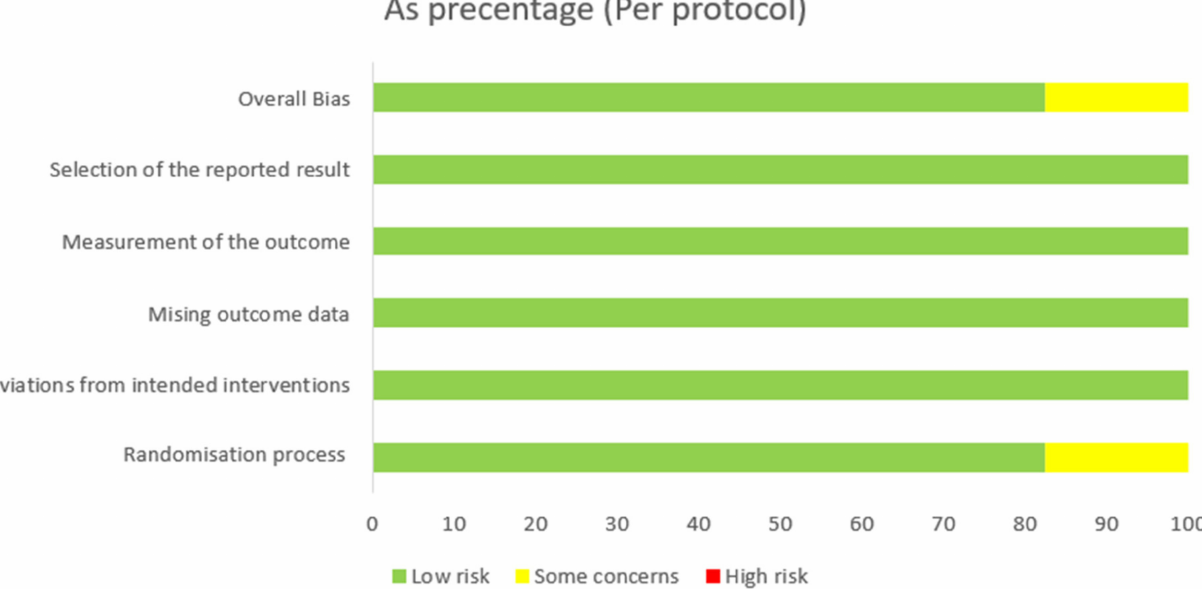
Figure A1. Risk of bias chart for 17 studies included in the review. Three studies (~18%) included were considered to have “some concerns” related to the randomisation process and overall